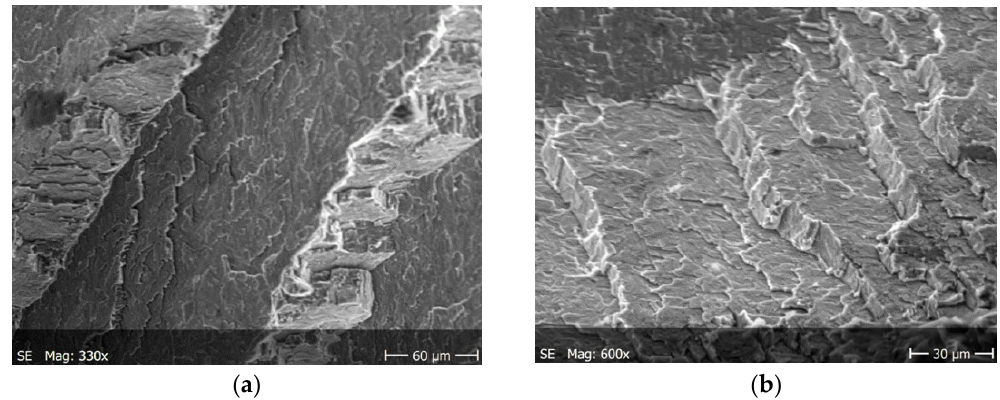
Figure 10. Fractures in the tested material after static tests for ( a ) a larger specimen area, ( b ) enlarged crack.